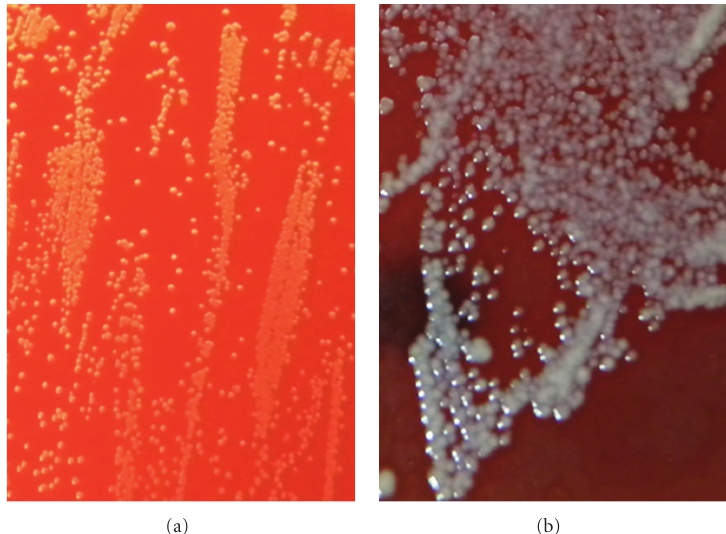
Figure 2: (a) Corynebacterium kroppenstedtii ( Ck ) isolation subculture on horse blood agar after 48h of incubation in aerobic conditions (original magnification, × 25). The first isolation was obtained after 4 days (not shown). (b) Ck isolation subculture on horse blood agar supplemented with 1% Tween 80 after 48 h of incubation in aerobic conditions (original magnification, × 25). The colonies were nonpig- mented, small (diameter less then 1mm), smooth, round, matt, and